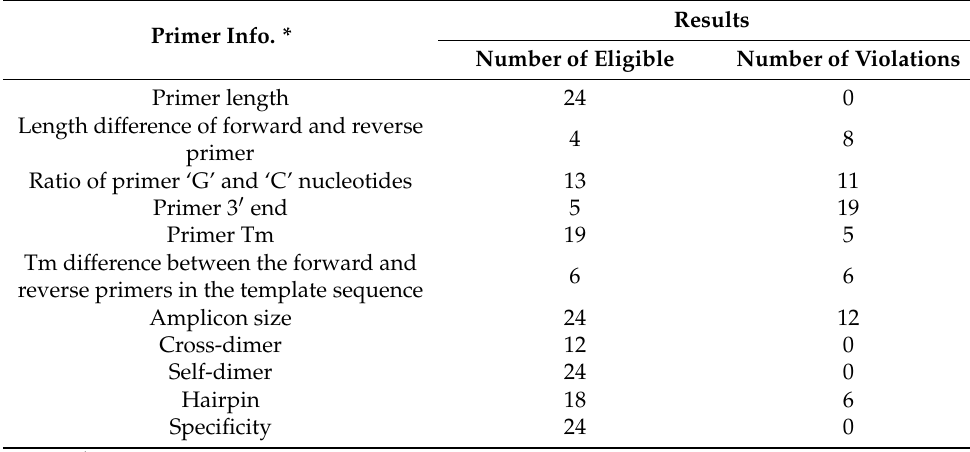
Table 3. Design results of mutagenic primers combined with REHUNT. The number of iterations and population size were set to 200 and 50, respectively. Results Primer Info. * Number of Eligible Number of Violations Primer length 30 0 Length difference of forward and reverse 6 primer